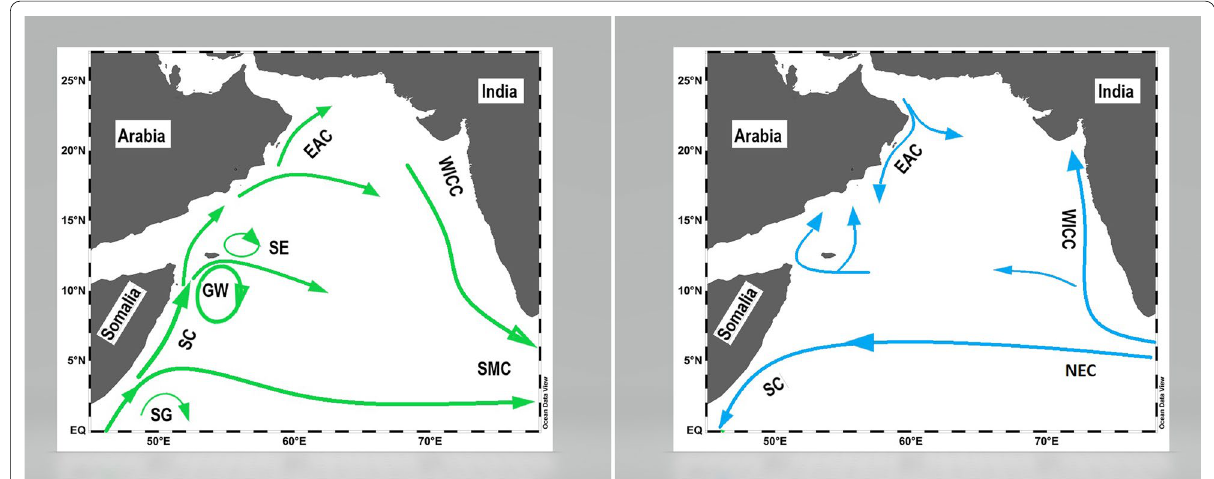
Fig. 1 Schematic map of surface currents of the AS. The left panel summer monsoon and right panel winter monsoon. Summer Monsoon Current (SMC), North Equatorial Current (NEC), Somali Current (SC), West Indian Coastal Current (WICC), East Arabian Current (EAC), Great Whirl (GW), Southern Gyre (SG) and Socotra Eddy